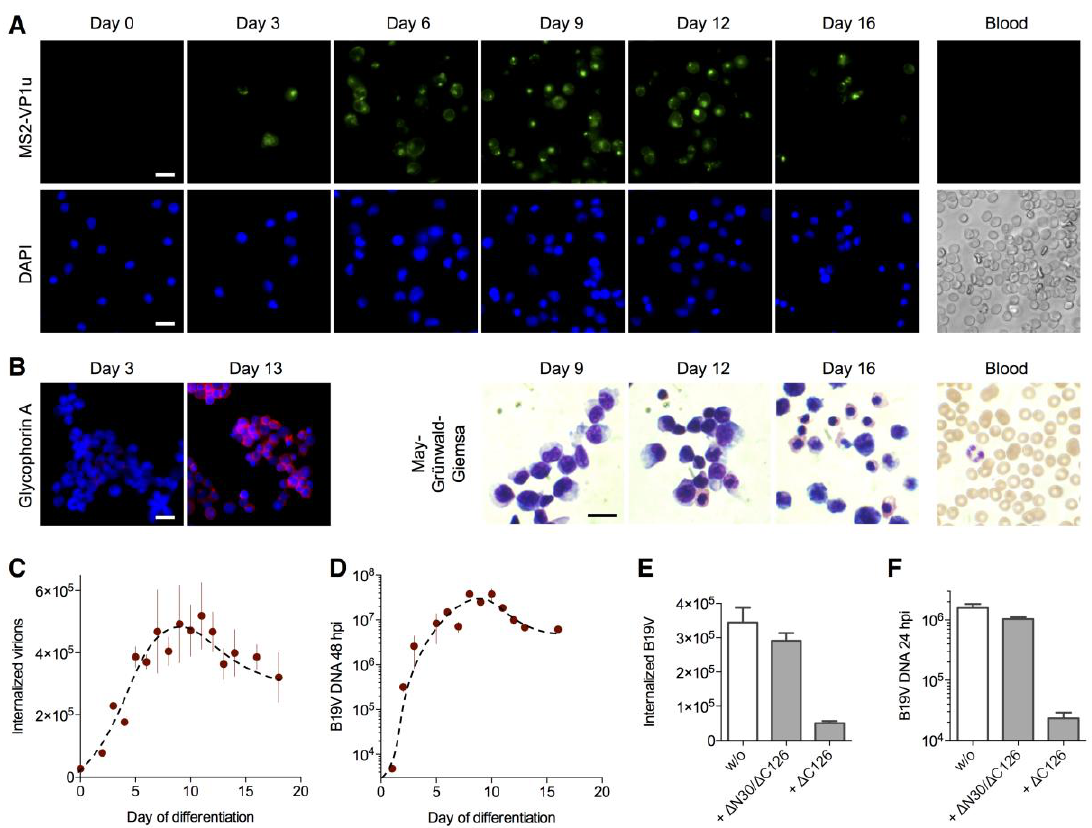
Figure 3. Native B19V and MS2-VP1u specifically target erythroid cell lines. ( A ) MS2-∆C126 VP1u and native B19V were incubated with the same mixed cell culture of non-adherent UT7/Epo cells, and adherent HeLa and MRC-5 cells. Cells were fixed and immunostained with an anti-B19V capsid antibody (860-55D [33]). Cell-specific internalization of MS2-∆C126 VP1u (green) and native B19V (magenta) was visualized by fluorescence microscopy. Scale bar: 100 µm (20× magnification), 15 µm (63× magnification); ( B ) Cellular uptake of native B19V into the different cell lines measured by qPCR ( n = 3); ( C ) Internalization of MS2-VP1u on normal and phorbol myristate acetate (PMA)-differentiated erythroleukemic K562 cells, visualized by fluorescence microscopy. Scale bar: 30 µm (63× magnification).